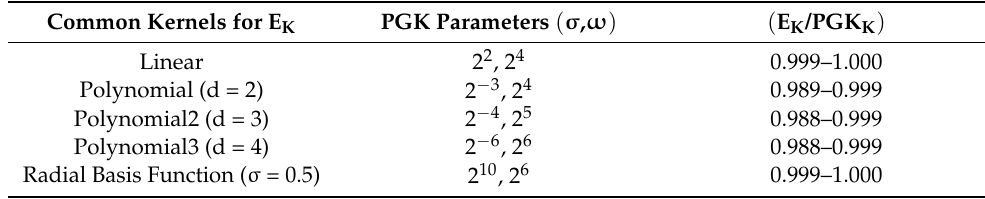
Table 12. The similarity measure ( E K /PGK K ) for JAFFE images.